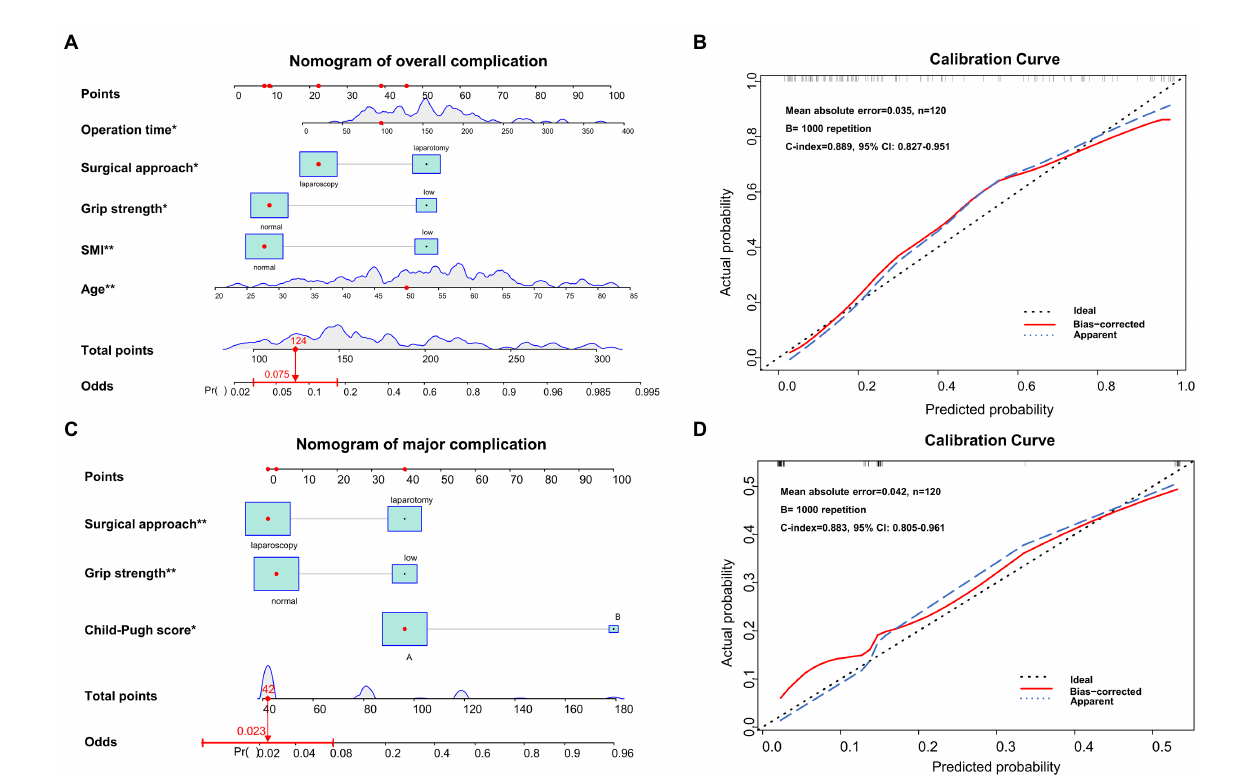
FIGURE 3 Nomograms and calibration curves for predicting overall complication and major complication after hepatectomy. (A) the nomogram predicting overall complications, (B) the calibration curve of the complication prediction model, (C) the nomogram predicting major complications, and (D) the calibration curve of the major complication prediction